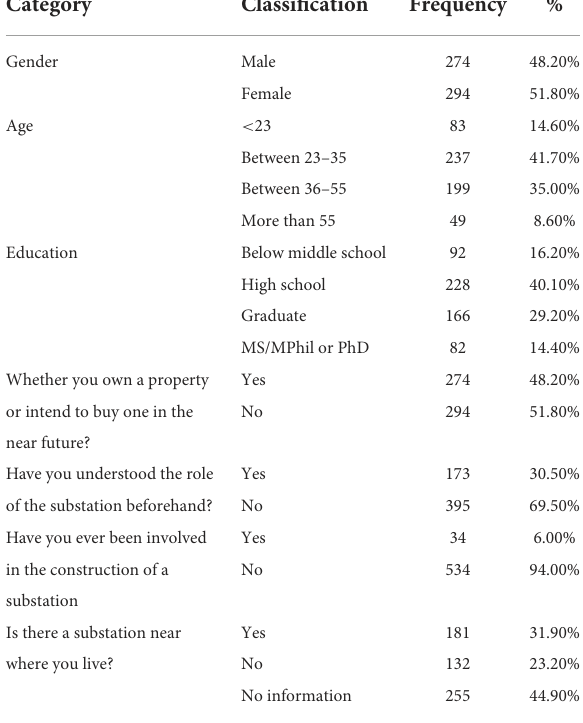
TABLE 1 Sample profiles of the